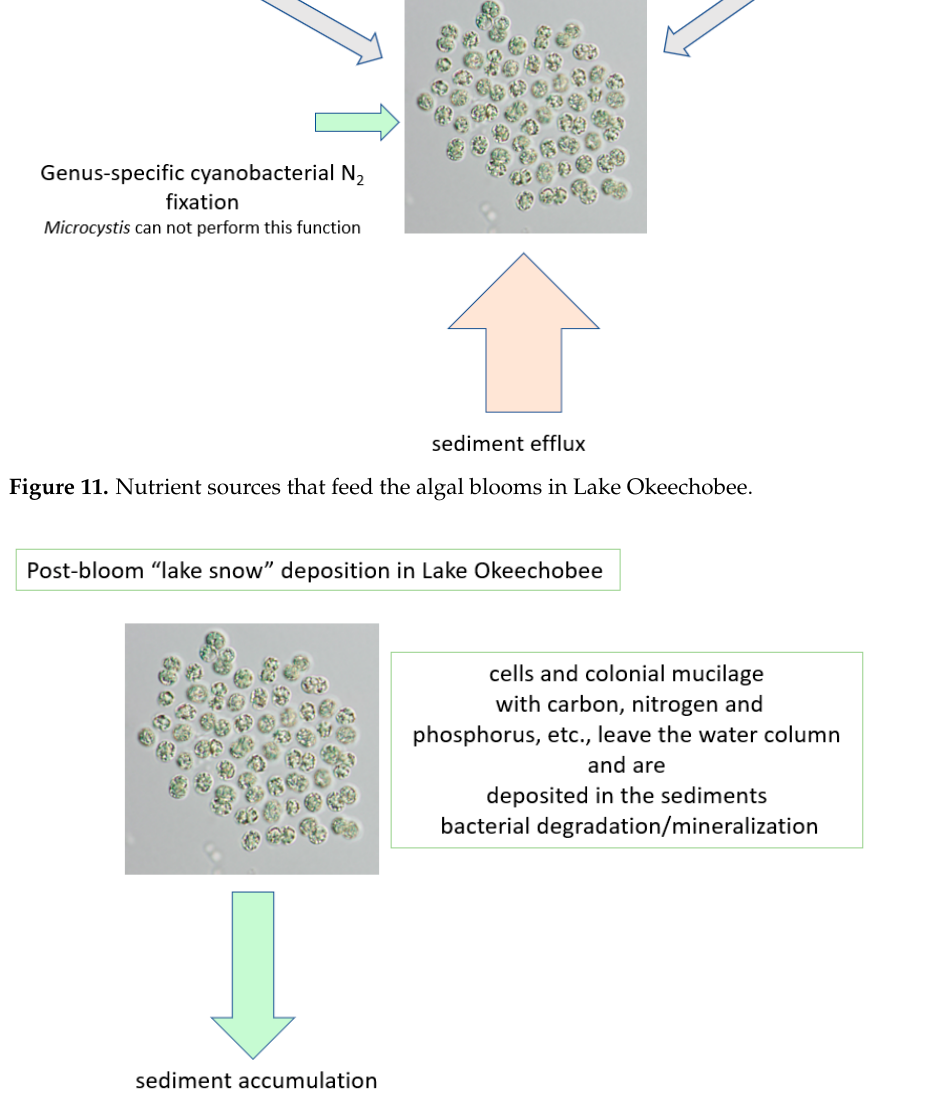
Figure 12. Post algal bloom “lake snow” deposition in Lake Okeechobee.